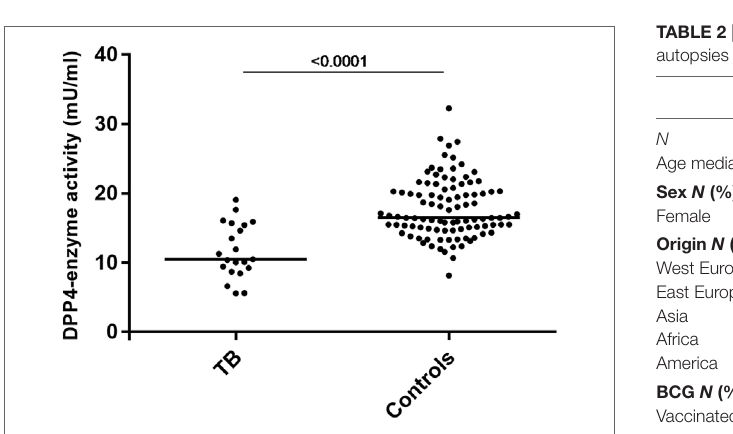
FigUre 3 | Decreased plasma DPP4 enzyme activity in tuberculosis (TB) patients. DPP4 enzyme activity in plasma determined using colometric assay in 21 patients with active TB and 98 healthy controls.